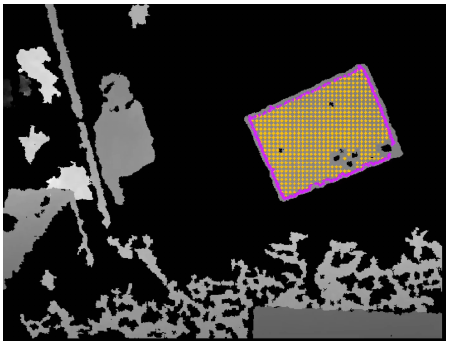
Figure 9. Labeling of depth camera data, with yellow pixels as detections and magenta pixels as boundary pixels